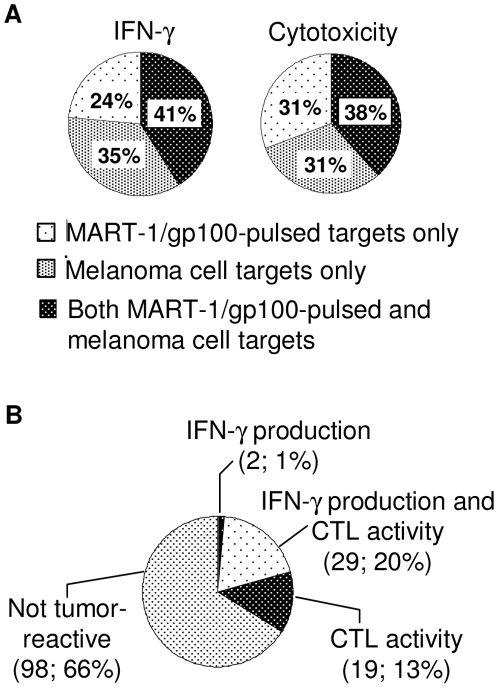
Tumor reactivity of TILs.(A) Summary of data from all HLA-A*0201+ TIL cultures that exhibited reactivity against melanoma cells (i.e. autologous tumor cells or HLA-A*0201+ melanoma cell lines) and/or peptide-pulsed T2 cells (i.e. MART-1 or gp100 peptides). The proportion of TIL cultures showing reactivity against MART-1/gp100-pulsed T2 cells only, melanoma cells only, or both MART-1/gp100-pulsed and melanoma cells is shown. IFN-γ data are from 17 TIL cultures; CTL data are from 26 TIL cultures. (B) Results from functional assays of all TIL cultures (for which relevant targets were available) are summarized. The number and proportion of TIL cultures exhibiting tumor reactivity (based on IFN-γ production, CTL activity, or both) or not exhibiting tumor reactivity are shown.